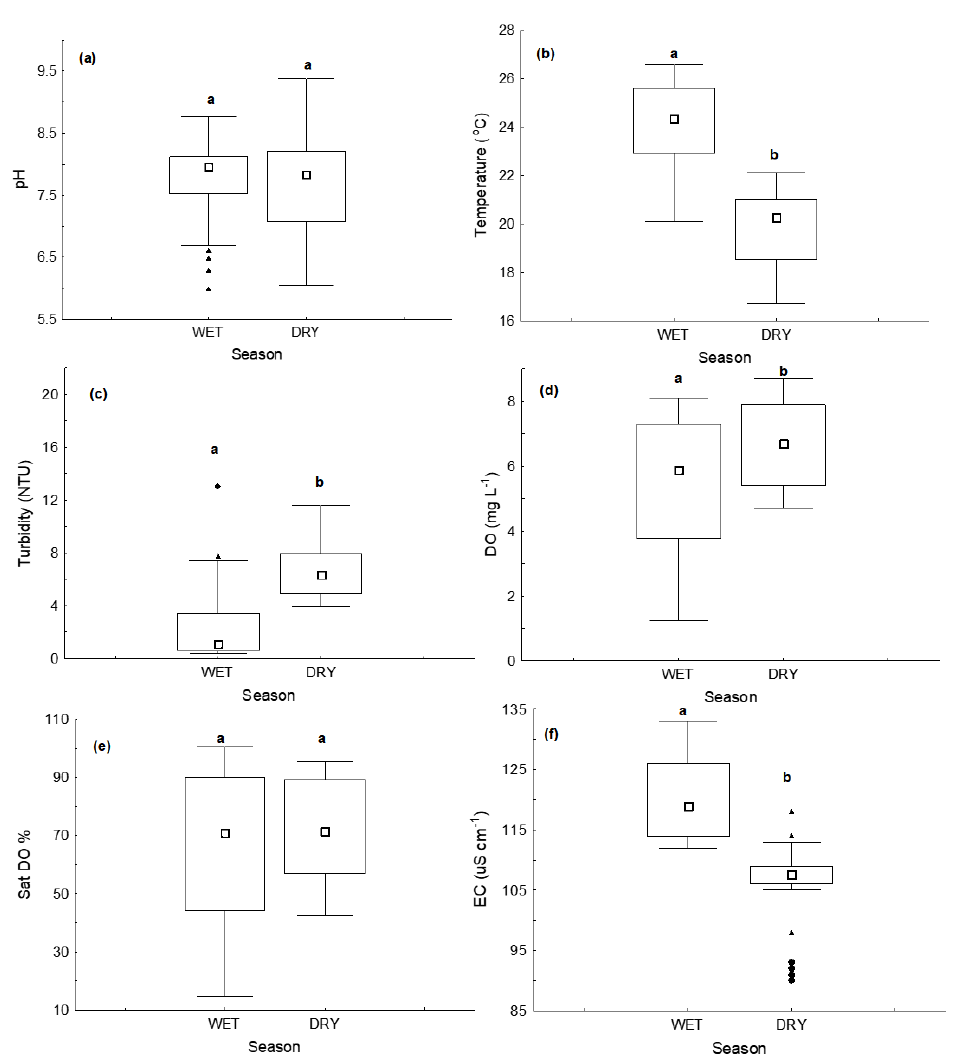
Figure 4. Box and whisker plots of seasonal variation in water quality variables: ( a ) pH, ( b ) T °C, ( c ) Turbidity, ( d ) DO, ( e ) Sat. DO %, ( f ) EC. Small white squares represent median values, boxes represent the interquartile range, range bars show the maximum and minimum values, black triangles represent the extremes and black diamonds show the outliers. Different letters (a and b) over box plots indicate a significant difference (Mann-Whitney U test, p < 0.05).